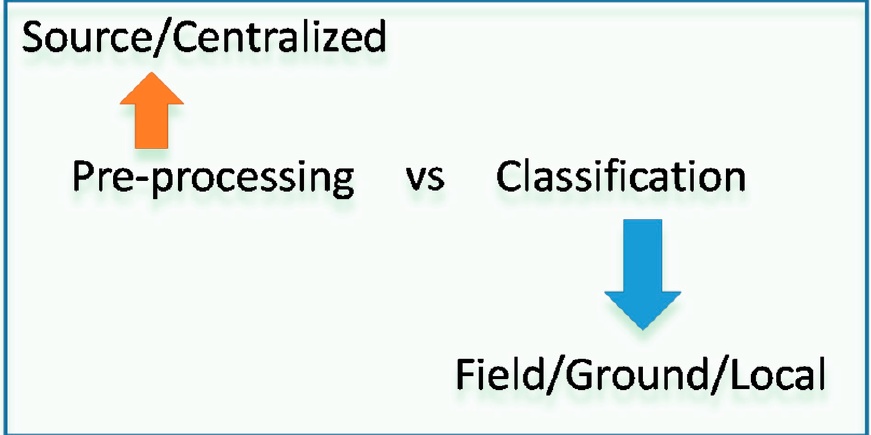
Figure 3. Conceptual framework of pre-processing and image classification showing centralized versus field/ground/local level processing.